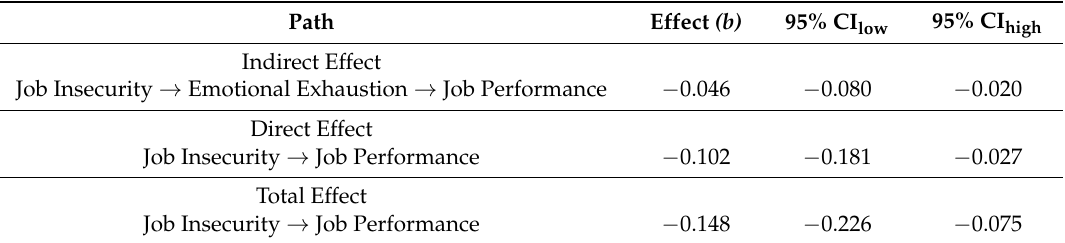
Table 2. Test of the mediation of emotional